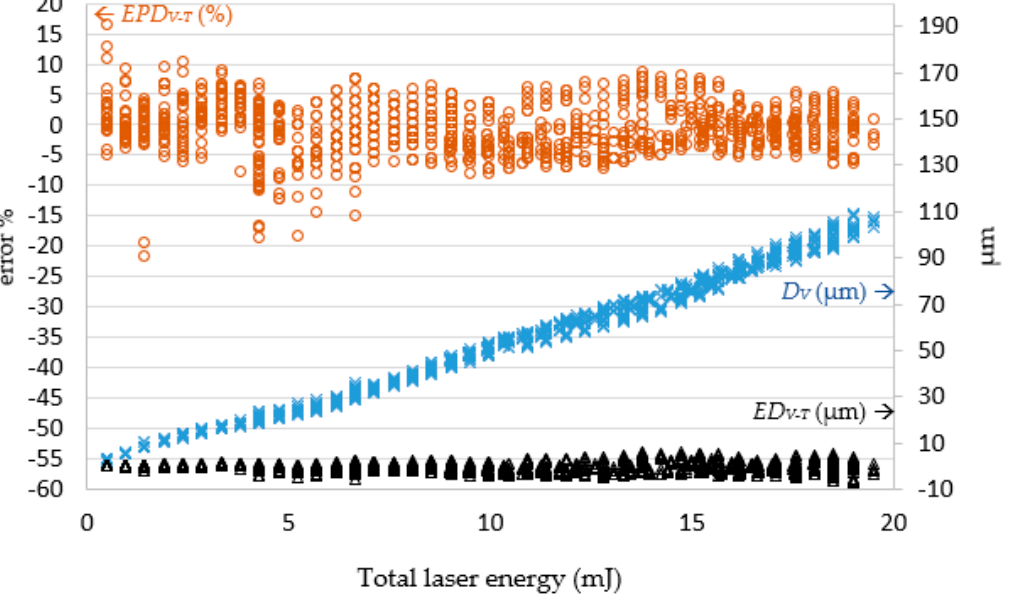
Figure 10. The error ED V − T between the target and actual hole depth ( D T , D V ) corresponds to the total